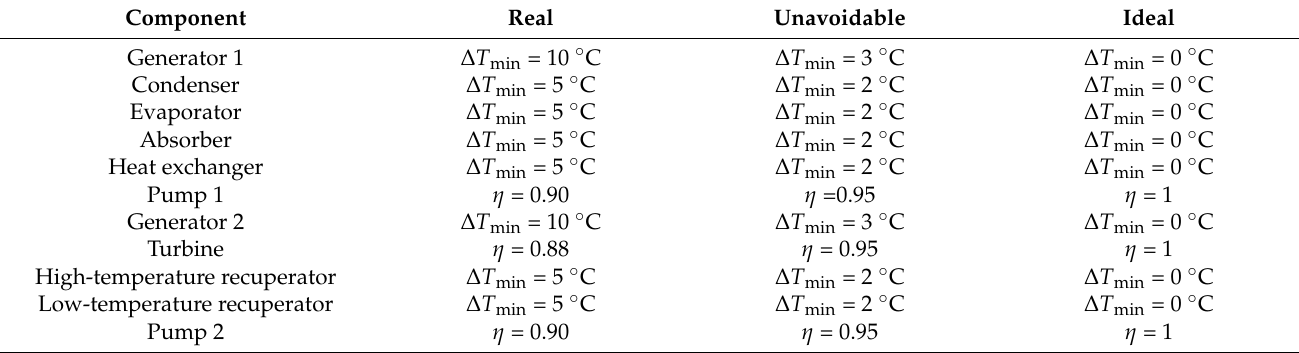
Table 3. Operational parameters in real, unavoidable and ideal conditions